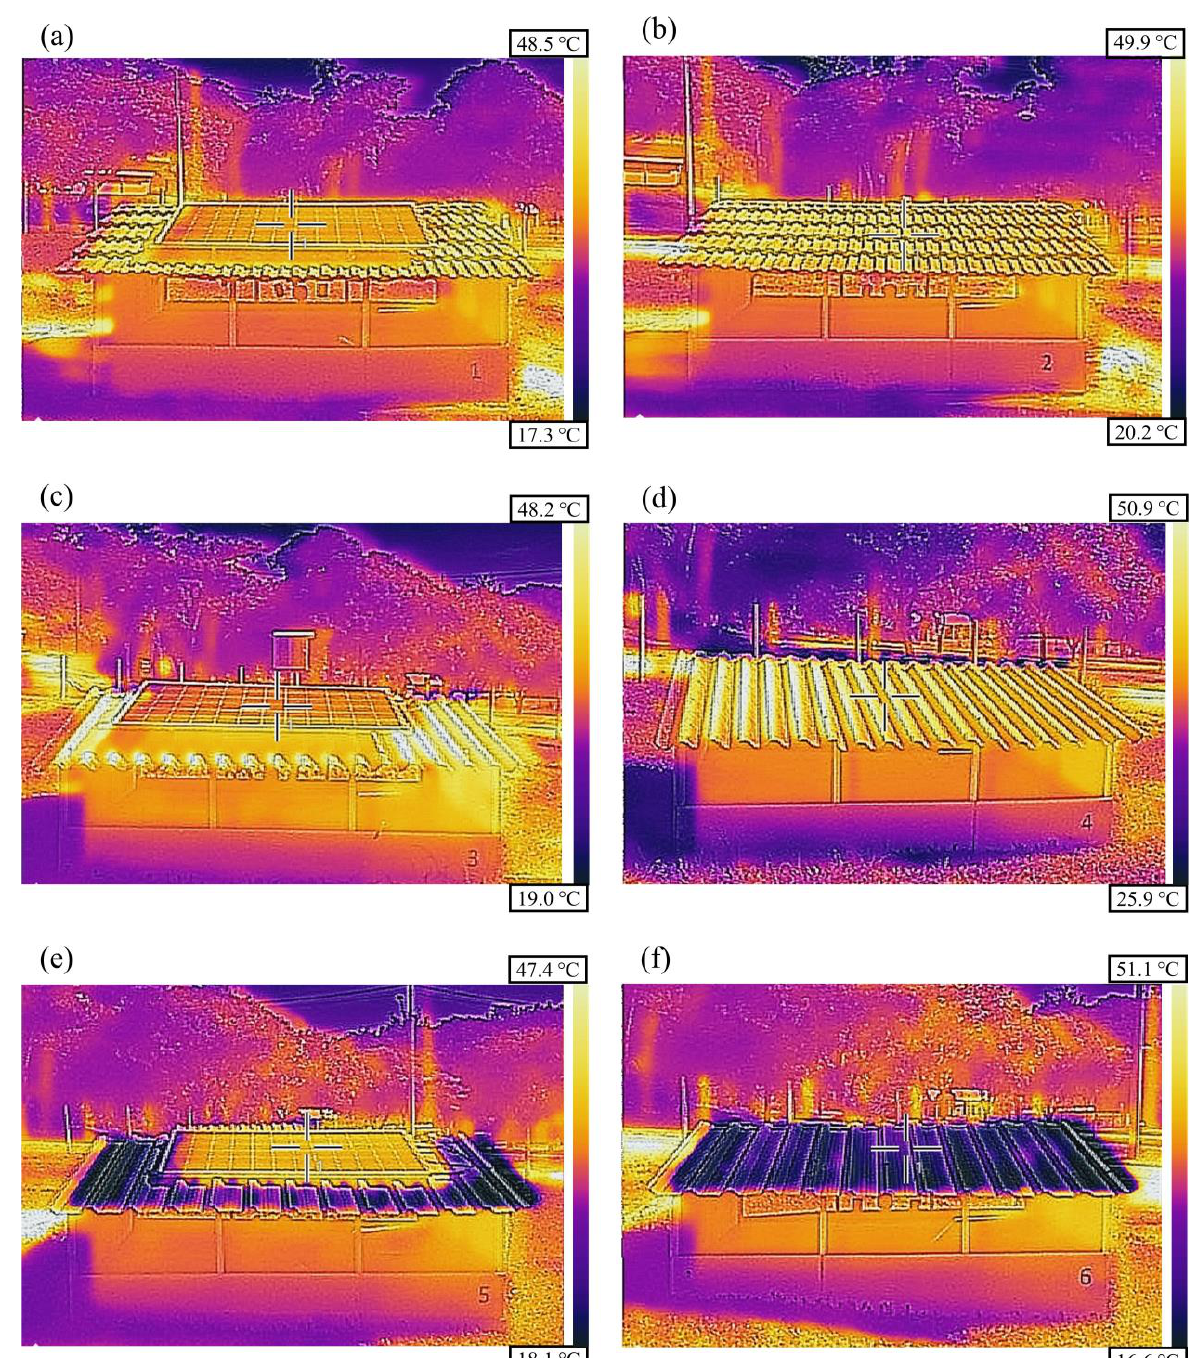
Figure 5. Infrared thermography of the prototypes at 15:00 h: ( a ) ceramic tile with photovoltaic panel; ( b ) ceramic tile; ( c ) fiber-cement tile with photovoltaic panel; ( d ) fiber-cement tile; ( e ) metallic tile with photovoltaic panel; and ( f ) metallic tile.